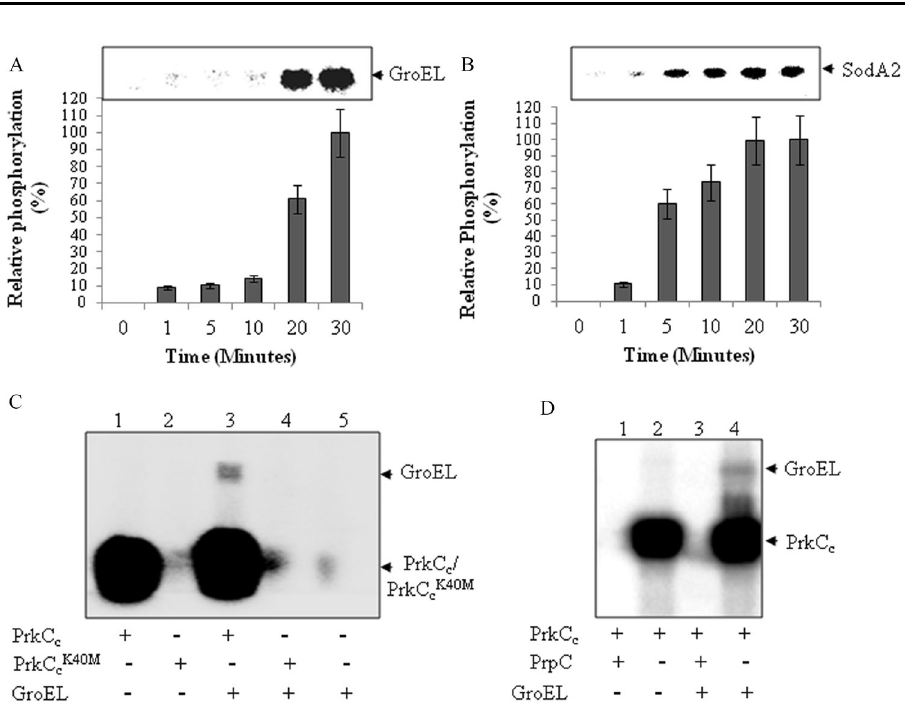
Fig. 2 Time-dependent phosphorylation kinetics of PrkC and reversible phosphorylation of GroEL: To validate GroEL as PrkC substrate (Tables 1, 2, and 3), we used recombinant GroEL (57.5 kDa) for in vitro kinase assays using the kinase domain of PrkC [PrkC c , 1-337 aa, ~40 kDa 14 ]. Autoradiogram shows Time-dependent phosphorylation of GroEL ( a ) and SodA2 ( b ), with autophosphorylated kinase (using cold ATP). Phosphorylation intensity at 30 min time point was taken as 100% and relative phosphorylation was calculated followed by normalization with the protein amount (Fig. S2). The corresponding autoradiogram is shown above the bar graph. The assay was performed twice and intensities were calculated three times each. Error bars represent SE of six independent calculations. c Autoradiogram showing in vitro phosphorylation of GroEL. PrkC catalytic domain (PrkC c , 1 µg) was used for phosphorylation (for 30 min) of puri fi ed GroEL (5 µg) and the kinase dead mutant (PrkC c -K40M) was used as a negative control. No phosphorylation was observed in the control reactions when the kinase inactive mutant PrkC c -K40M was used. 14 d Autoradiogram showing in vitro dephosphorylation of PrkC-phosphorylated GroEL by Ser/Thr phosphatase PrpC (1 µg)